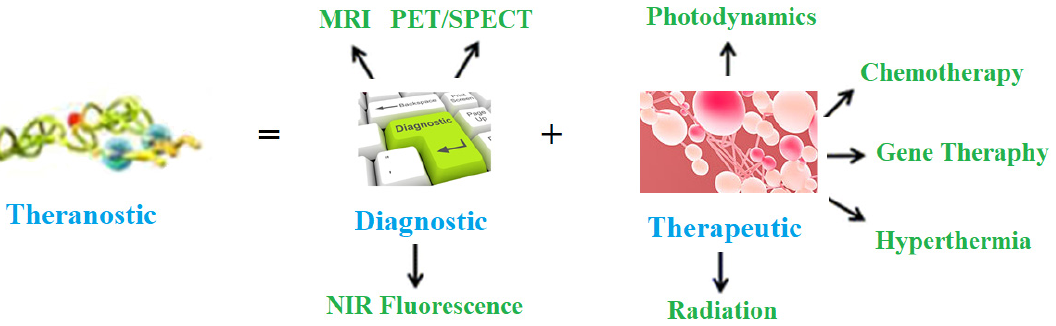
Figure 1. The schematic representation of polymeric nano-partcles (NPs) theranostic approach.